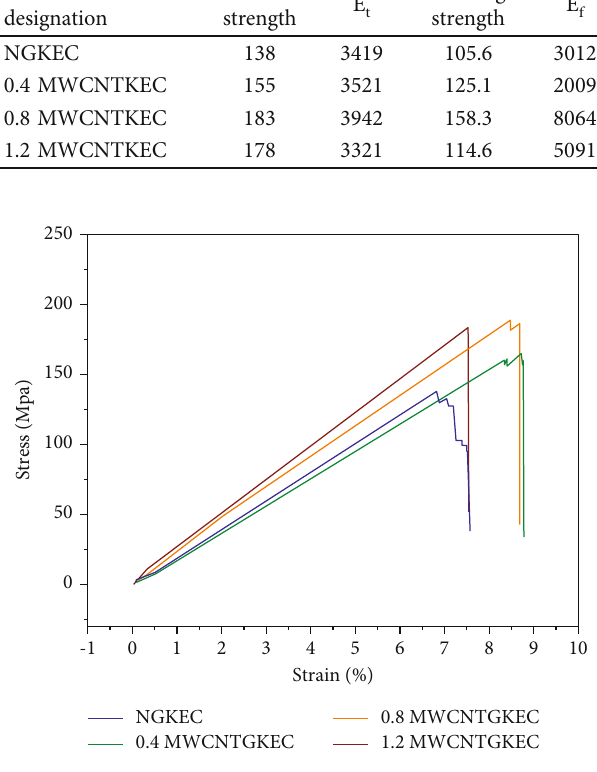
Figure 4: Plot of stress-strain data comparing neat and hybrid composites for tensile strength. Table 5: Glass/Kevlar/epoxy composites enhanced with NEAT and MWCNT at high hardness.